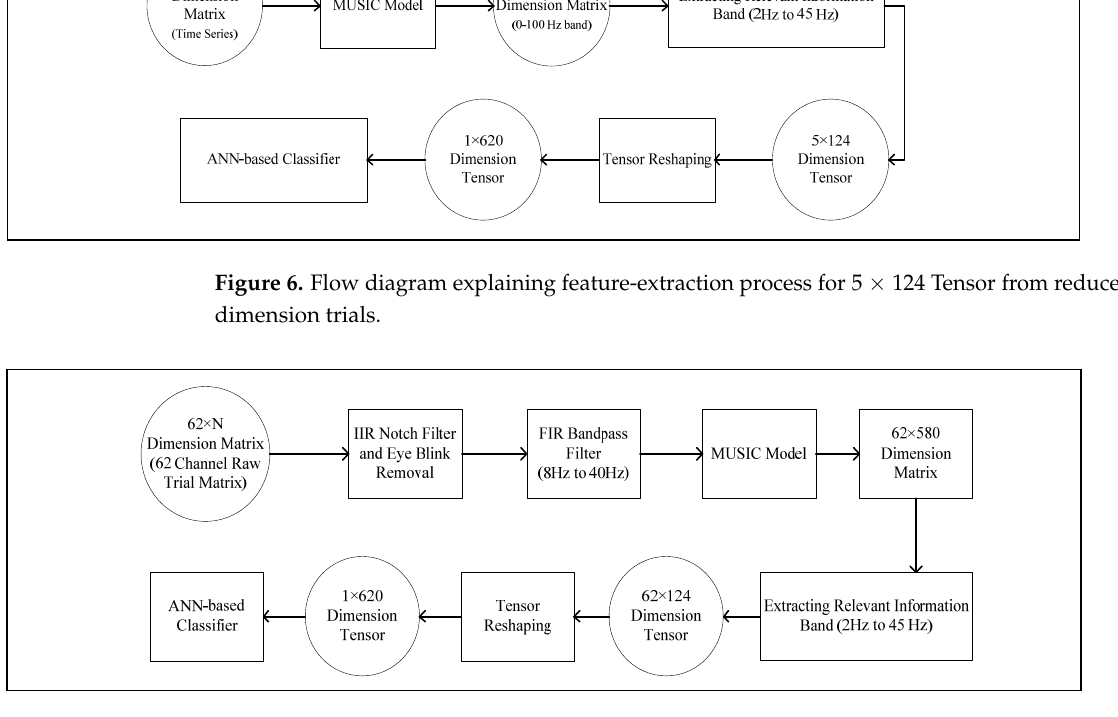
Figure 7. Flow diagram explaining feature-extraction process for 62 × 124 Tensor from raw 62 × N dimension